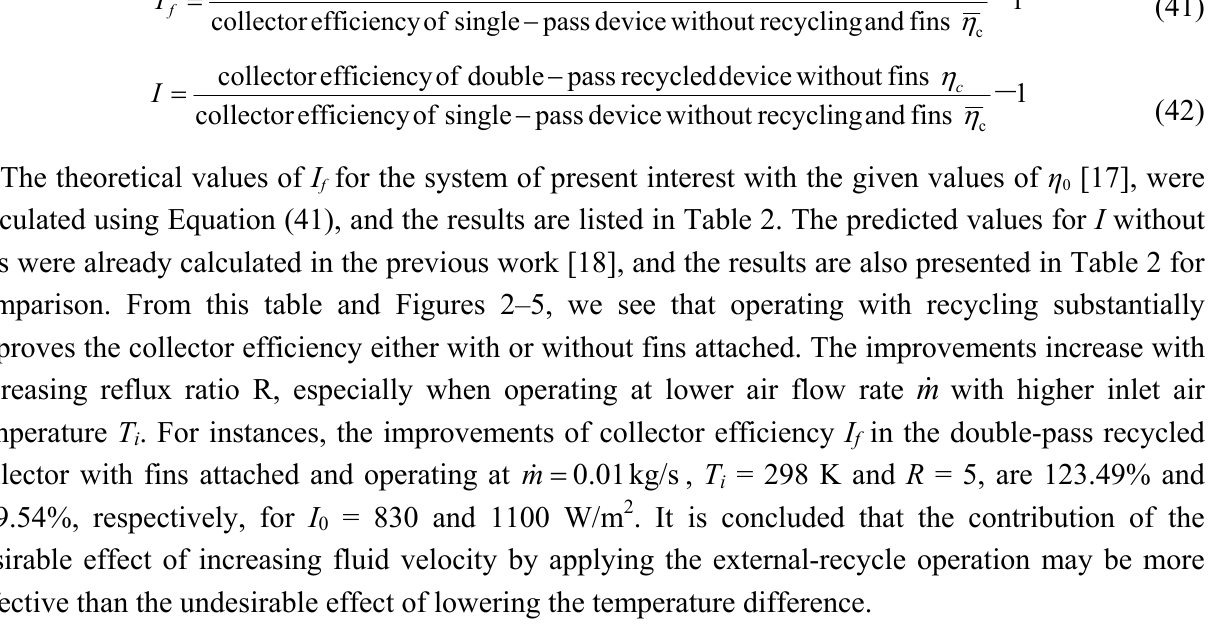
Table 2. The improvement of performance for: ( a ) I T (K) m  i